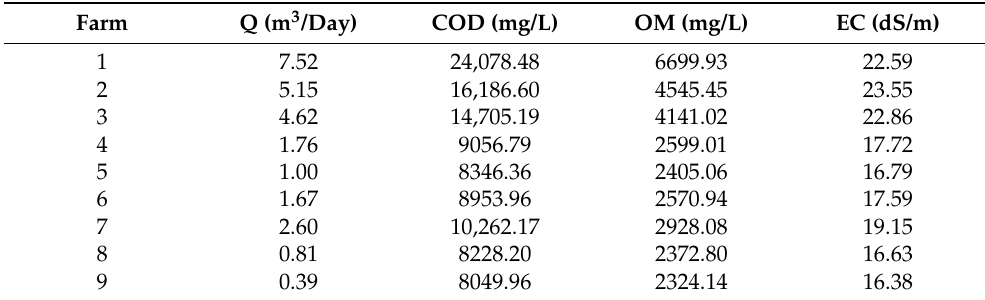
Table 4. Characterization of farms and livestock